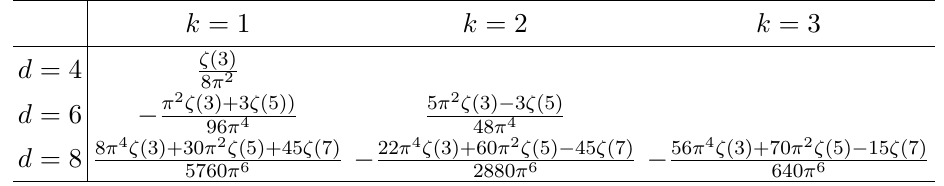
for the (cid:3) k φ theories for the first few values of k and d ∂